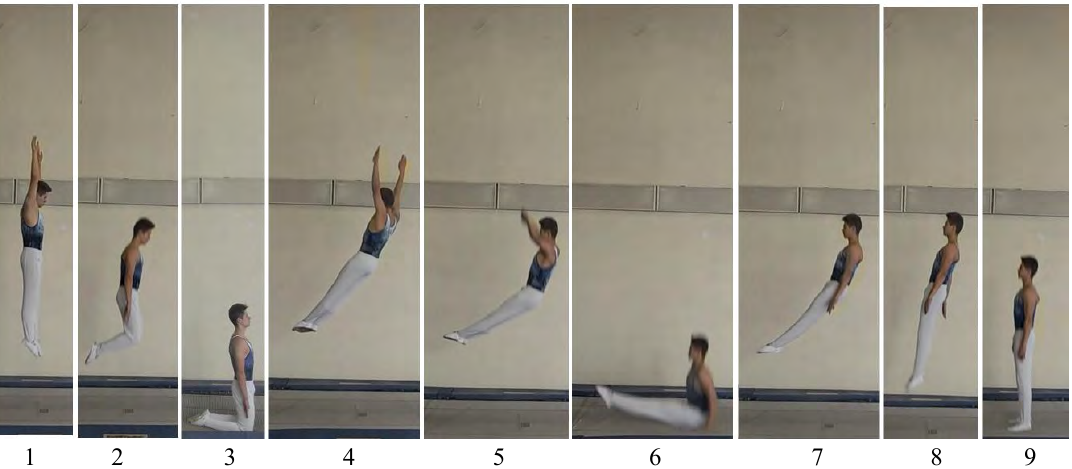
Fig. 13. Combination 1. Temp jumping (shot 1); jump in stance on knees (shots 2 – 3); jump upward with left turn by 180° and landing in sitting position (shots 4 – 6), then stop (shots 7 – 9). Recommendations: in jump combination it is necessary to coordinate arms movements (in ascending part of trajectory arms go upward and in descending part – downward with accented arm moving to the side of turn (to the left or to the right)). Pay attention to accuracy of turn and taking sitting position with hands on network and fingers directed forward. Fulfill combination 2-4 times to each side.